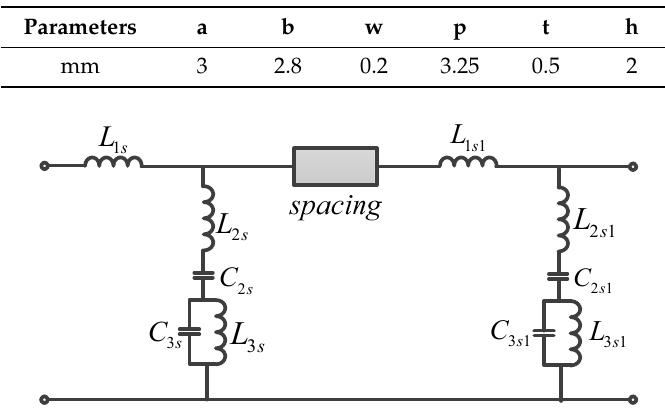
Figure 5. The equivalent circuit of harmonic suppression metasurface element. Appl. Sci. 2017 , 7 , 1240